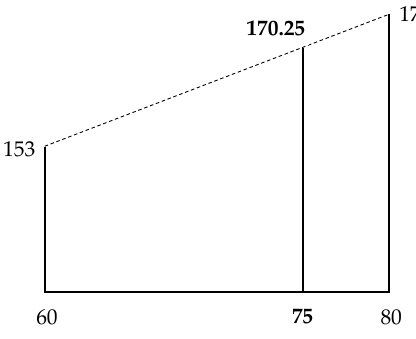
Figure 10. Method of determining the value of the A parameter based on Table 1.